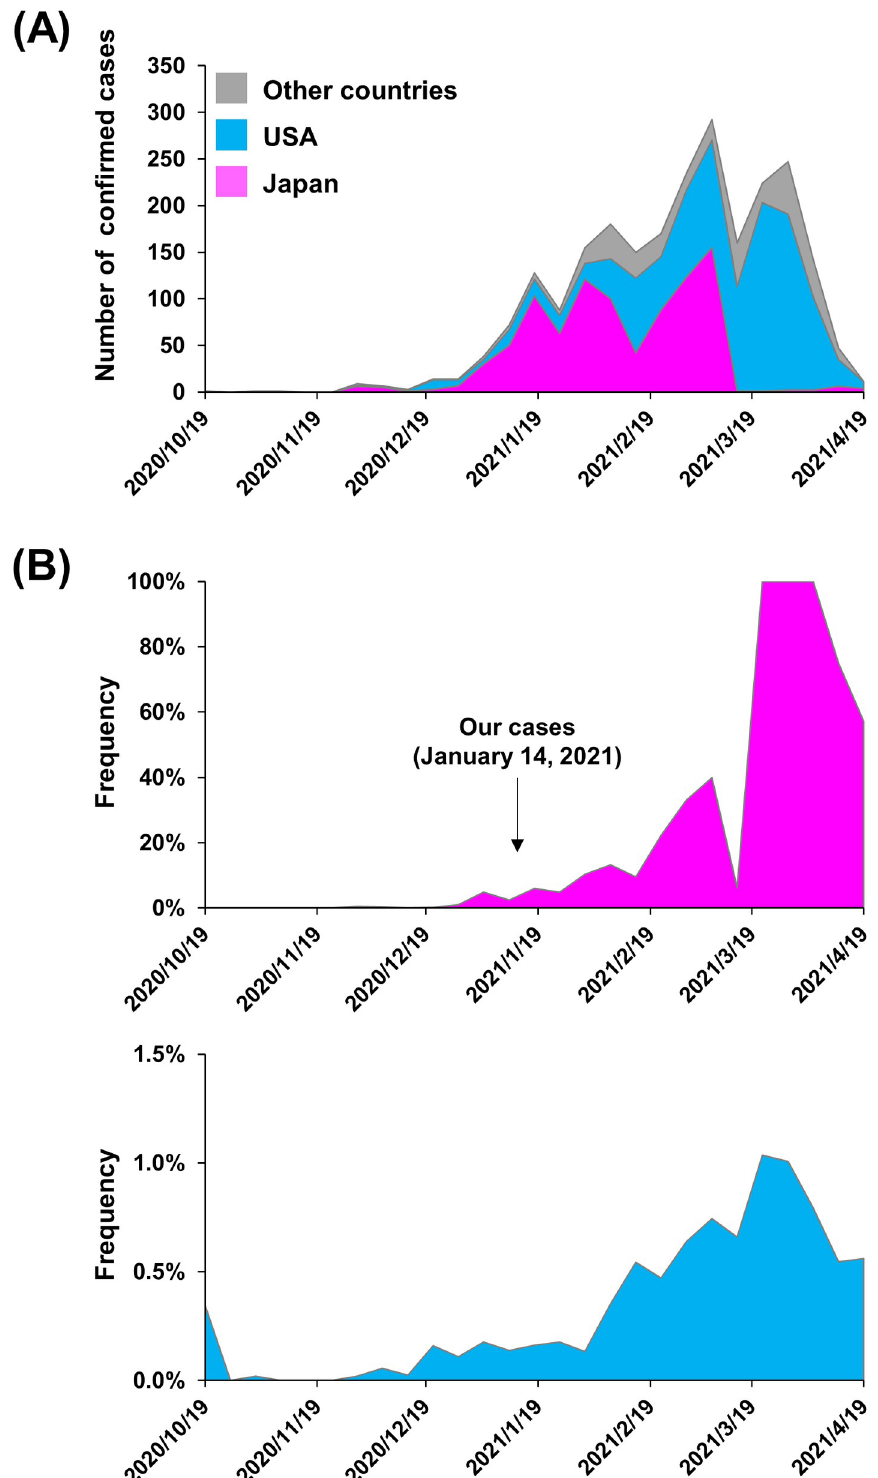
Fig 2. Timeline of SARS-CoV-2 R.1 lineage emergence and country-specific percentages of global cases. ( A ) Timeline of the number of confirmed cases of infection with R.1 lineage SARS-CoV-2. The plot, created based on the data in Table 1, shows the case load for Japan (pink), the United States (light blue), and other countries (gray). ( B ) The percentage of R.1 lineage SARS-CoV-2 strains relative to the total number of registered samples during the period